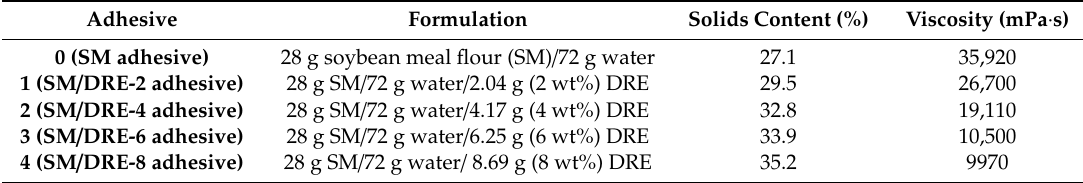
Figure 1. Flow diagram of the study of soybean meal-based adhesive enhanced with DRE. Table 1. The composition and properties of